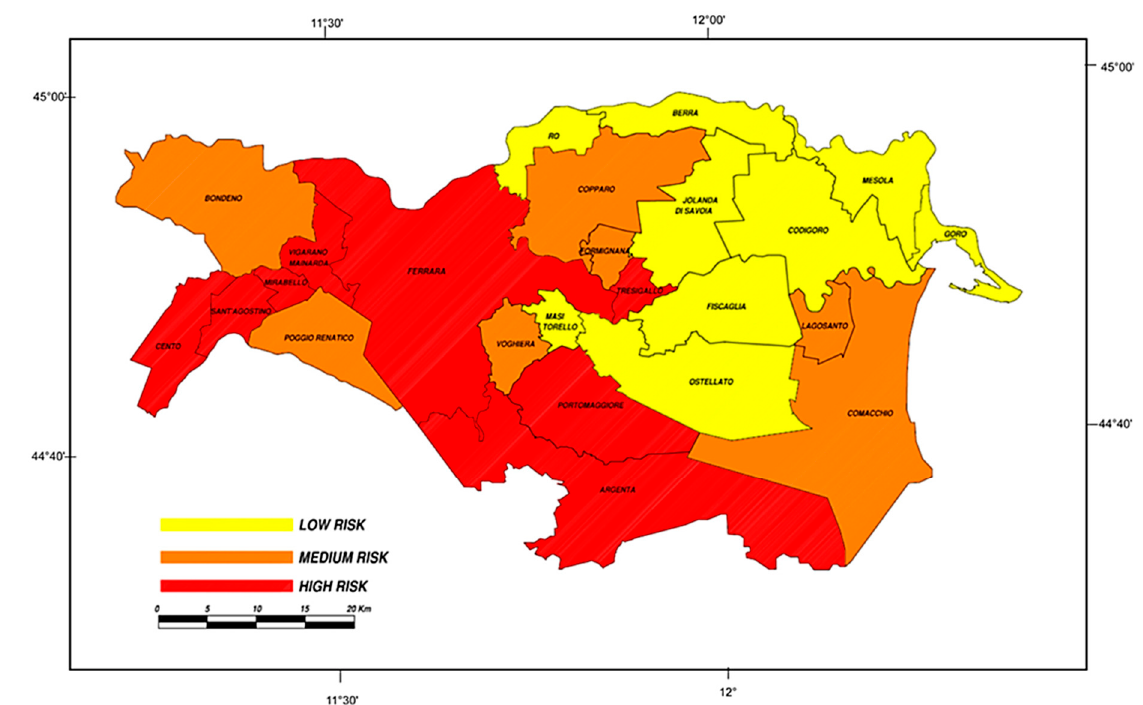
Figure 2. An example of multiple-risk map for the Ferrara province [15].